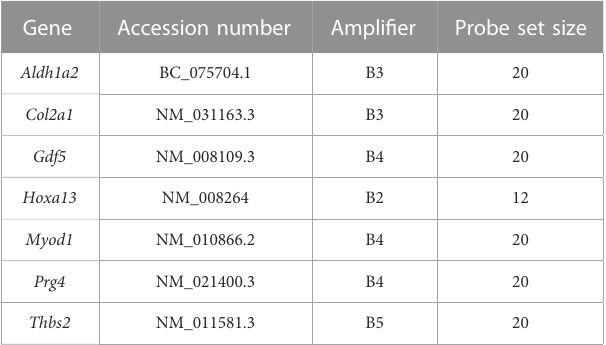
TABLE 1 HCR RNA-FISH probe sets. Below is the list of probes used for HCR RNA-FISHinthisstudy,includingtheHCRampli fi erpairedwitheachprobeand the probe set